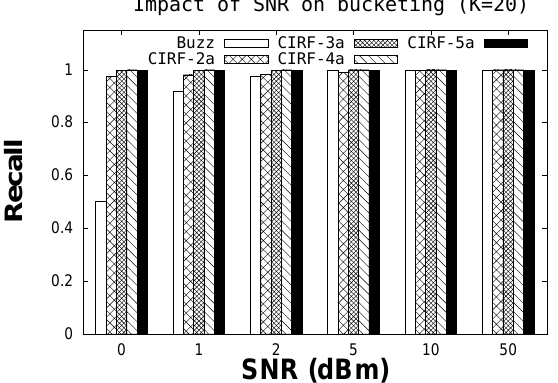
Figure 7. Buzz vs. CIRF bucketing.